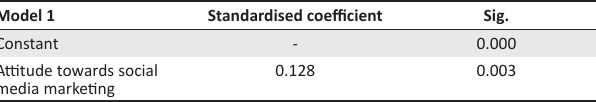
TABLE 8: Regression extracts for Hypothesis 11.